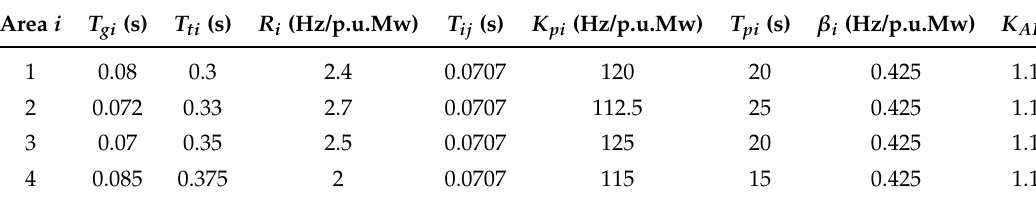
Table 3. The parameters of the four-area interconnected power